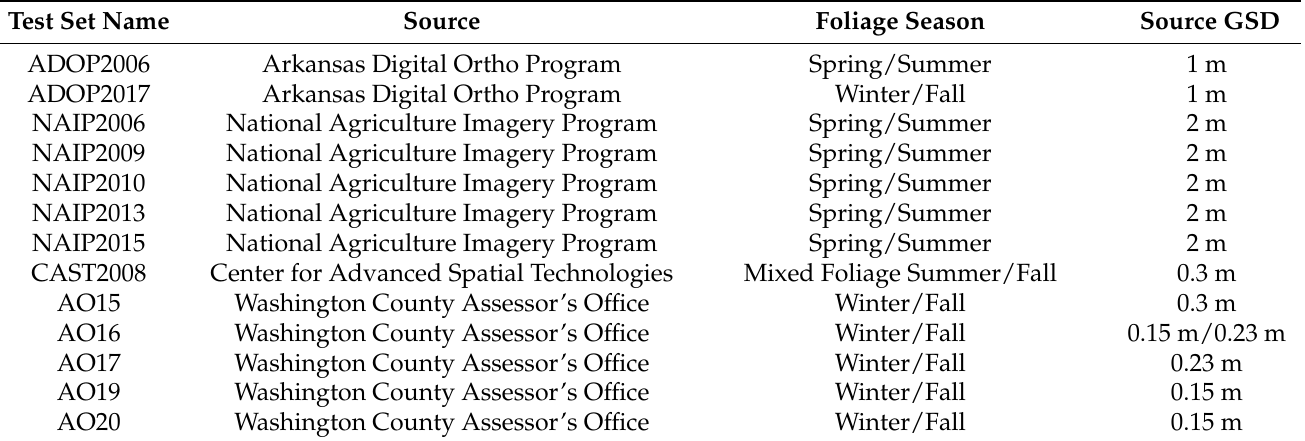
Table A1. Data set